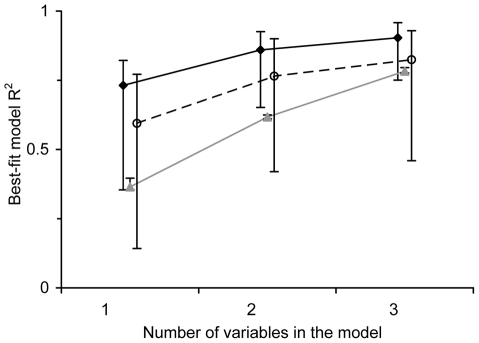
Fraction of the variation in vegetation attributes (median and range) explained by the descriptive (—♦—), predictive (- -○- -) and null (—▴—) models using a different number of textural attributes as explanatory variables.For the descriptive and null models conventional R
2 values are reported, while for the predictive models R
2
CV is reported, so the values are not strictly comparable (see Methods for explanation).